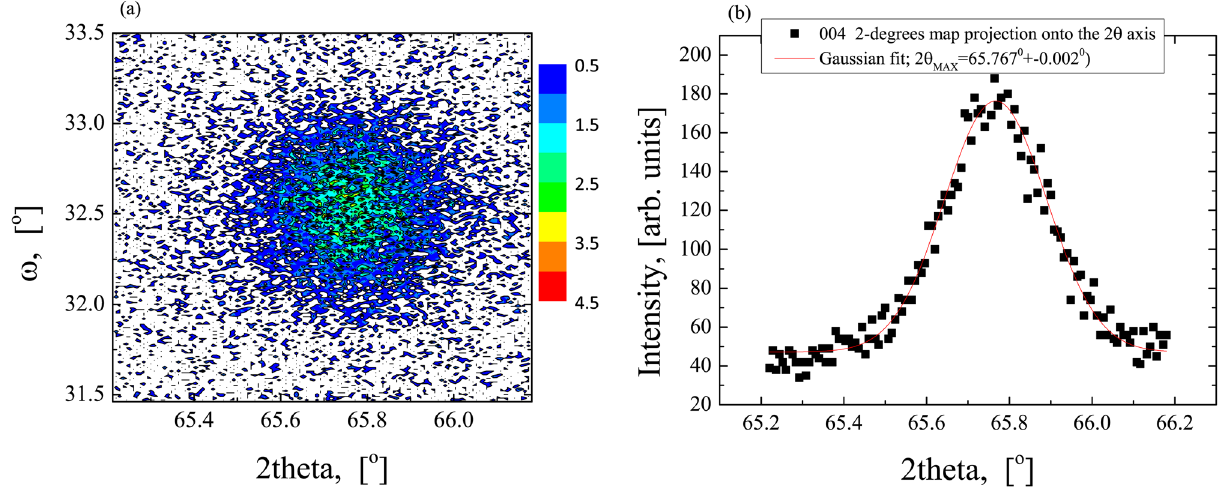
Figure 4. The X-ray intensity distribution around the (004) reflection ( a ) and nod projection into the 2θ axis ( b ) for the 50-nm-thick CFMS layer grown on the Ag buffer.